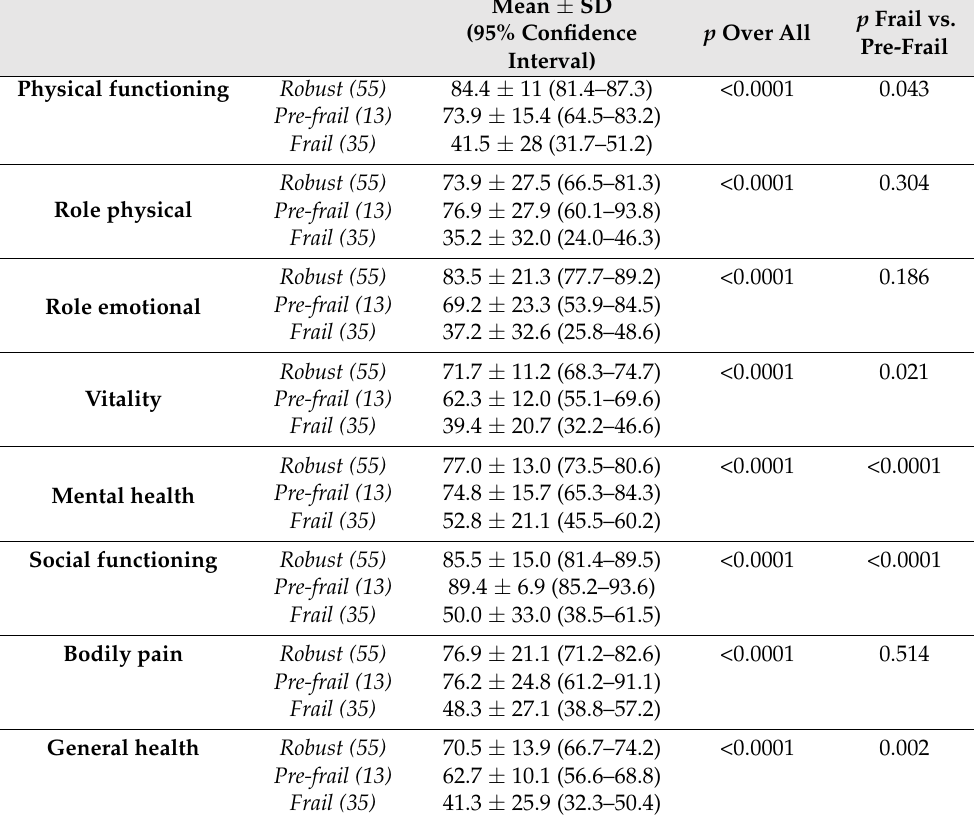
Table 2. Quality of life of the subjects classified according to the FP criteria . Mean and SD with CI are shown, and the p -values were calculated with one-way